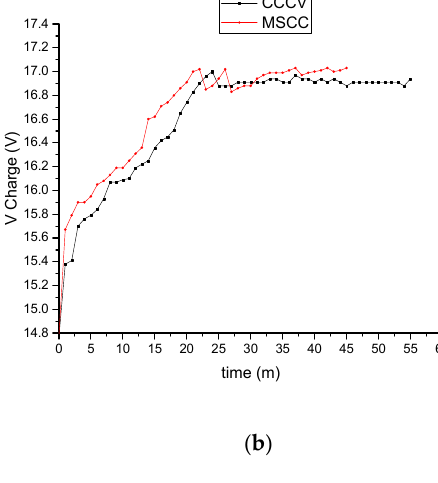
Figure 11. Charging voltage: ( a ) 2S; ( b ) 4S.